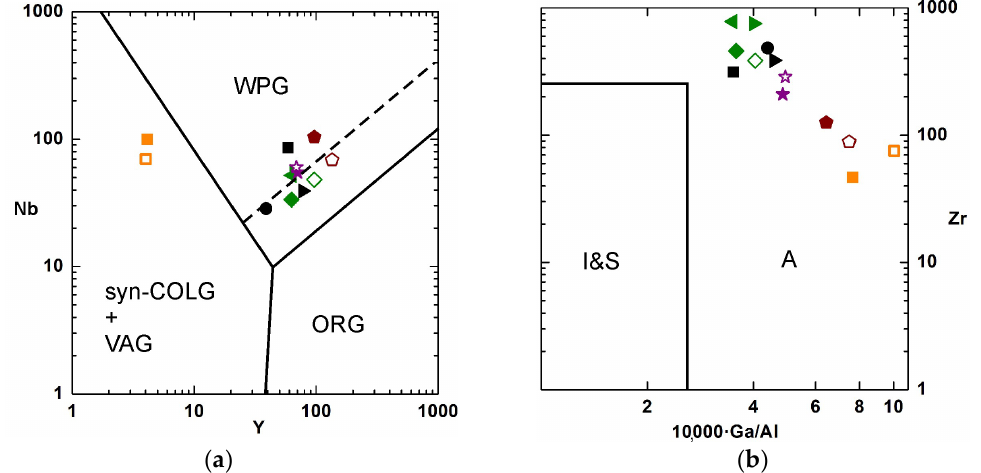
Figure 11. Tectonic-magmatic discrimination diagrams: ( a ) Nb-Y [56] and ( b ) Zr-10,000 Ga/Al [57]. All values are presented in ppm. WPG, within plate granite; ORG, ocean ridge granite; syn-COLG, syn-collision granite; and VAG, volcanic arc granite. The dashed line represents the upper compo- sitional boundary for ORG from the anomalous ridge segments. A, I, S: type of granitoids. The legend is the same as that presented in Figure 9.